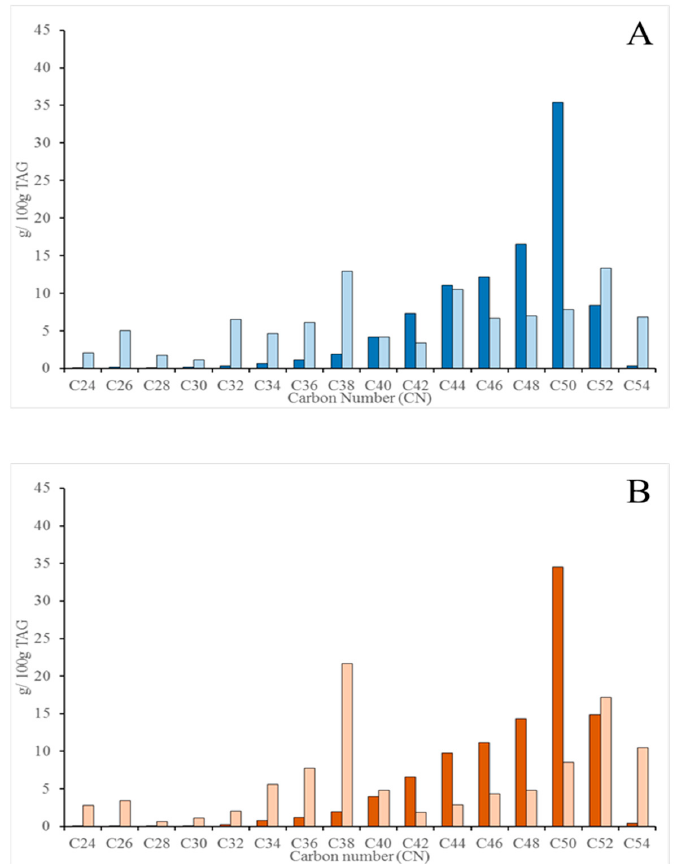
Figure 2. Distribution of the acylglycerols molecular species (%), in HC samples, according to their carbon atom number (CN). ( A ) raw HC samples (undigested ■ and digested ■ ). ( B ) pasteurized HC samples (undigested ■ and digested ■ ). Significant differences were observed when each pair of CN value was compared except for the CN40 and CN52.